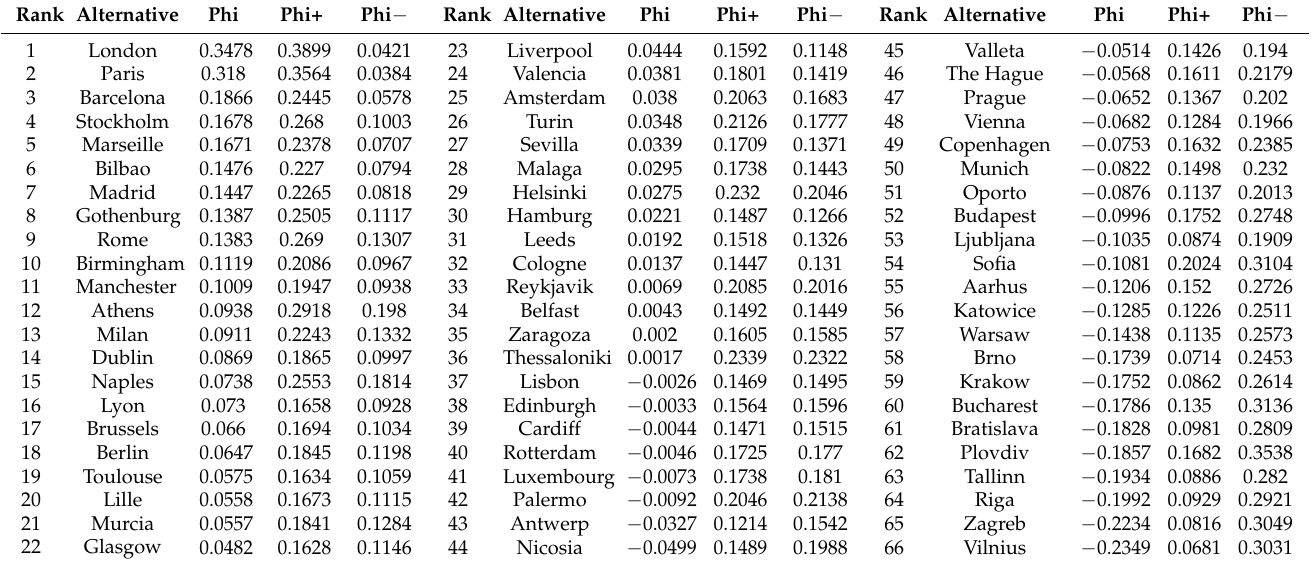
Table 4. Final ranking.